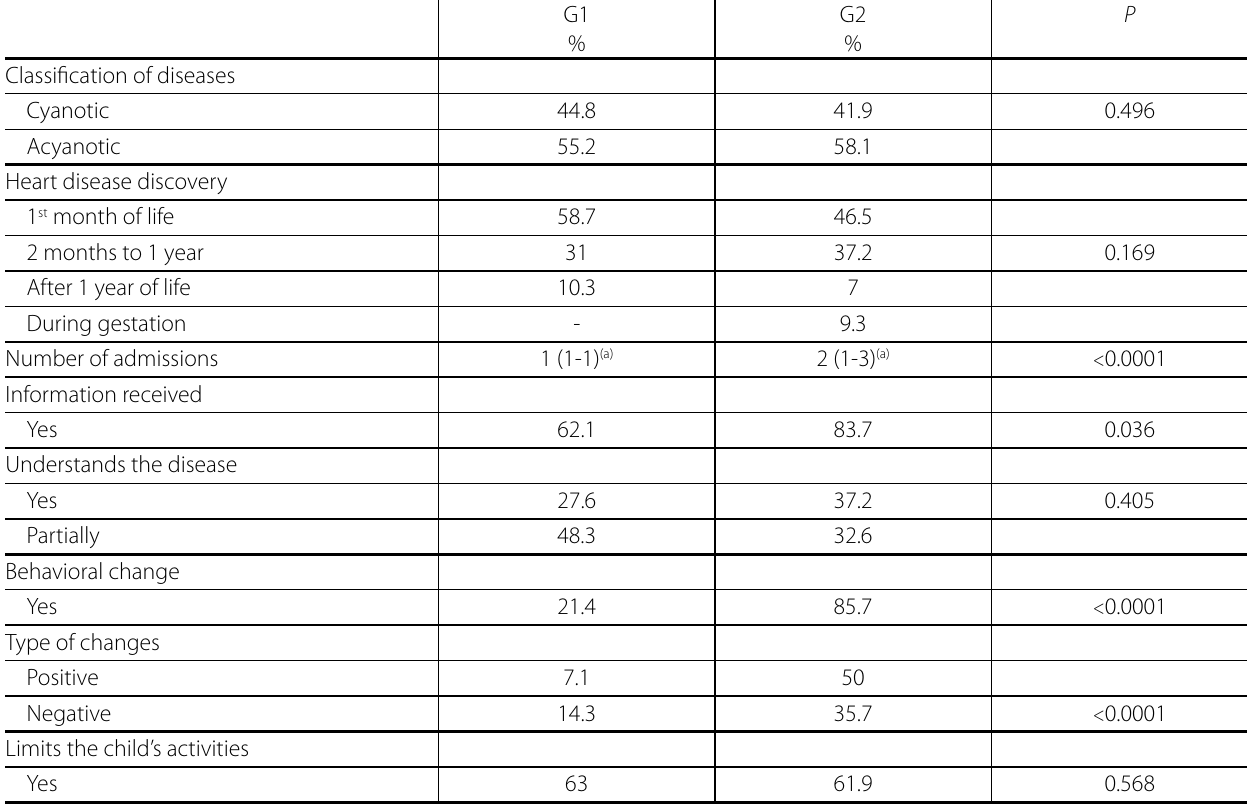
Table 2. Overview of congenital heart disease (G1 and G2) (n=72).